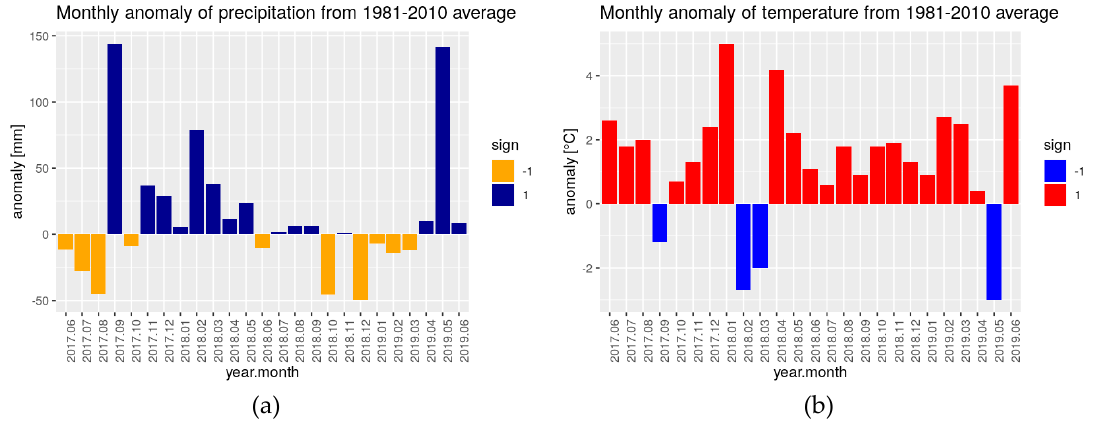
Figure 3. Monthly anomaly of precipitation ( a ) and air temperature ( b ) in the period from June 2017 to June 2019 based on 1981–2010 climate normal.